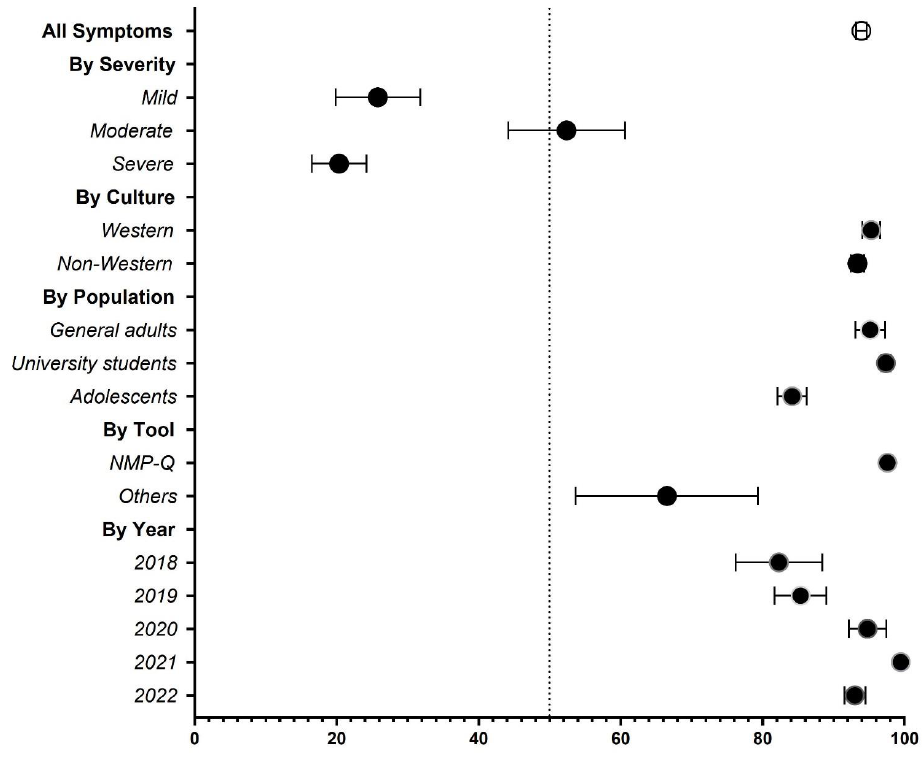
Figure 3. Summary forest plot of nomophobia.